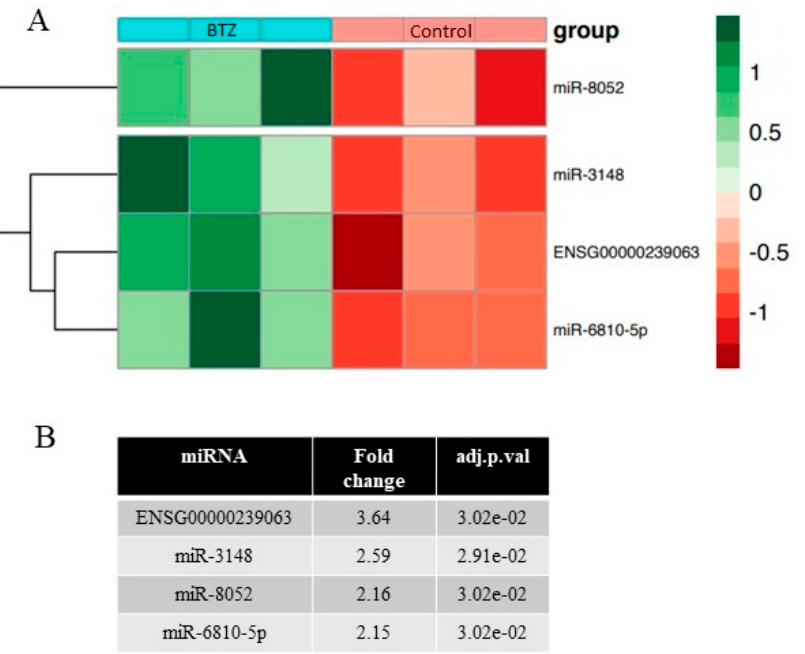
Figure 5. ( A ) Expression of selected miRNAs presented as a heatmap. Red color means decreased miRNA expression and green increased miRNA expression. ( B ) Fold change for miRNAs in BTZ-treated vs. control cells.